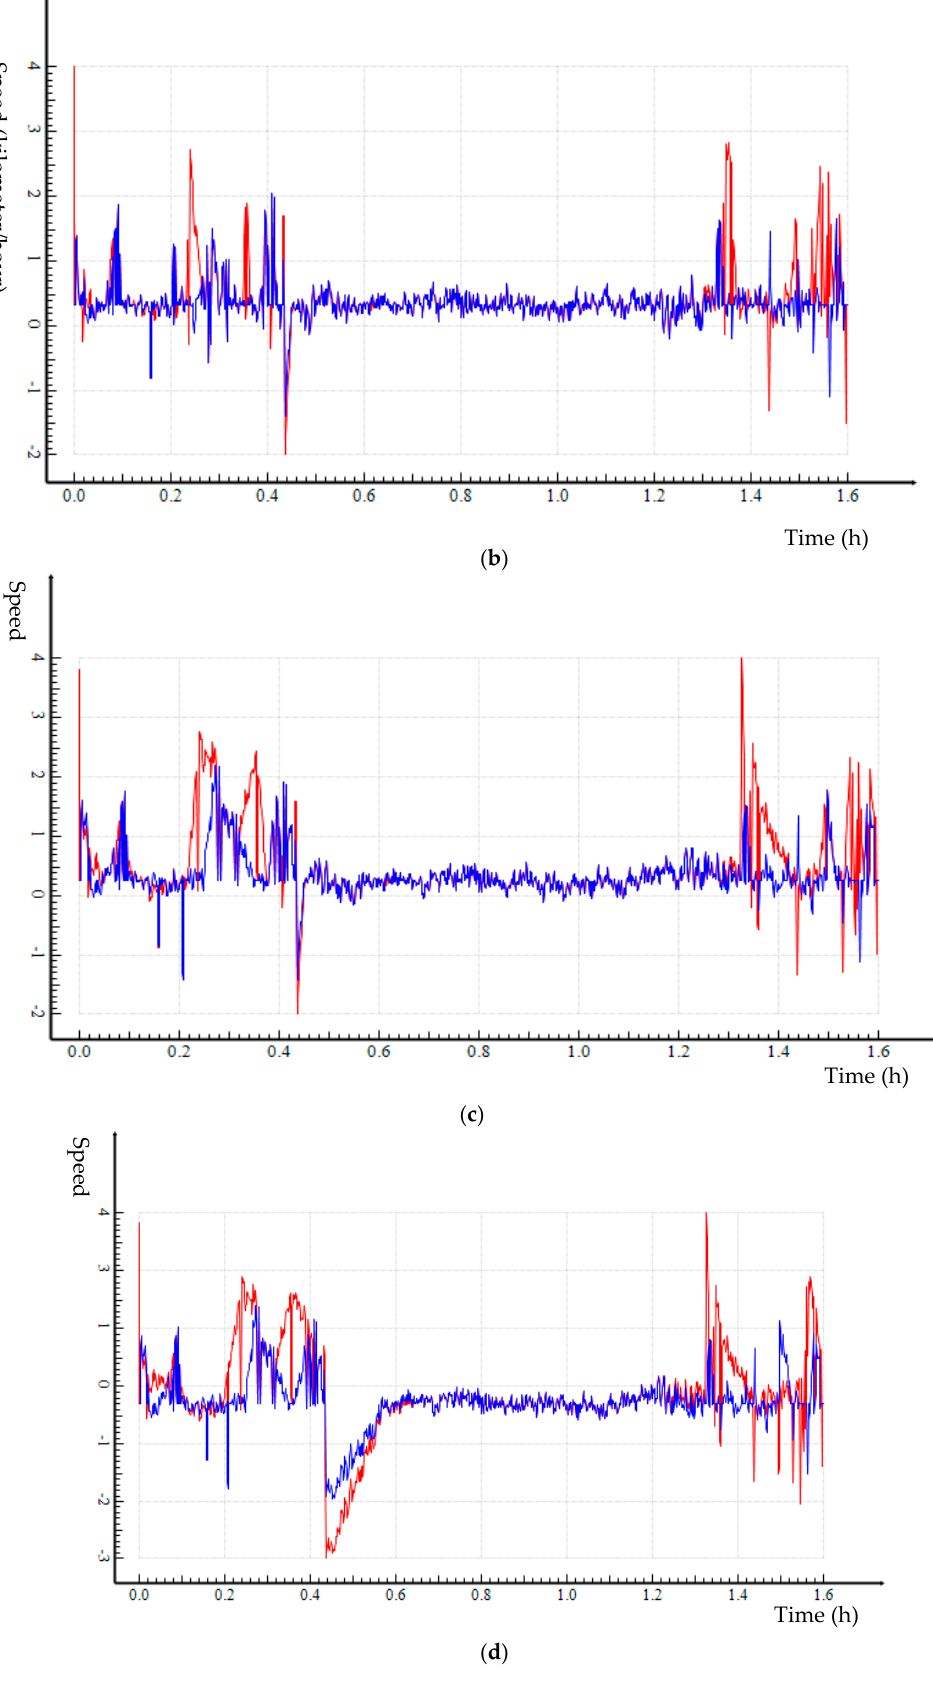
Figure 10. Speed loss in the post-simplification data of Trajectory 1 using DP and EDP algorithms with a distance threshold of: 1-m ( a ); 5-m ( b ); 10-m ( c ); and 25-m ( d ).